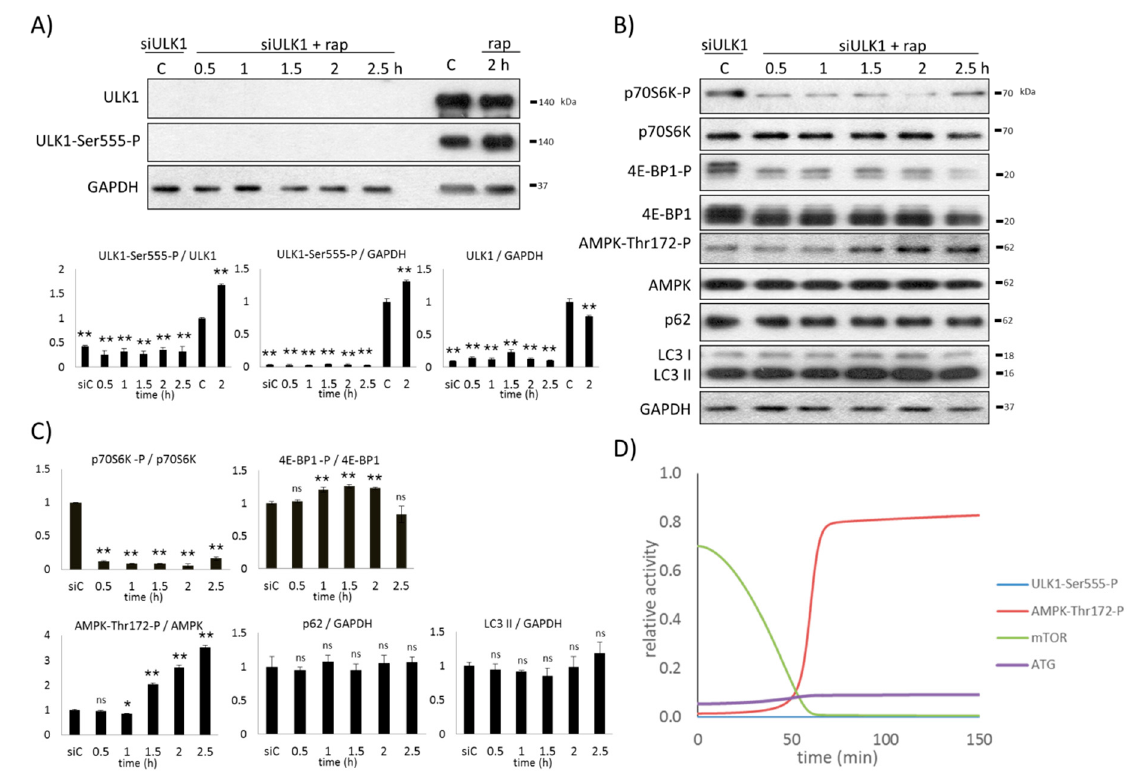
Figure 5. Silencing of ULK1 arrests autophagy induction upon rapamycin treatment. ULK1 was silenced by siRNA in HEK293T cells, followed by 100 nM rapamycin treatment in time. ( A ) Test of the ULK1 silencing by immunoblotting, total level of ULK1 and ULK1-Ser555-P were followed. GAPDH was used as the loading control. Densitometry data represent the intensity of ULK1 and ULK1-Ser555-P normalized for GAPDH and ULK1-Ser555-P normalized for total level of ULK1. ( B ) The markers of autophagy (LC3, p62), AMPK, and mTOR (p70S6K-P, 4E-BP1-P) were followed by immunoblotting. GAPDH was used as the loading control. ( C ) Densitometry data represent the intensity of p62 and LC3 II normalized for GAPDH, p70S6K-P normalized for the total level of p70S6K, 4E-BP1-P normalized for the total level of 4E-BP1, and AMPK-Thr172-P normalized for the total level of AMPK. For each of the experiments, three independent measurements were carried out. Error bars represent standard deviation, asterisks indicate statistically significant di ff erence from the control: ns—nonsignificant; * p < 0.05; ** p < 0.01. ( D ) Computer simulation of rapamycin treatment. The relative activity